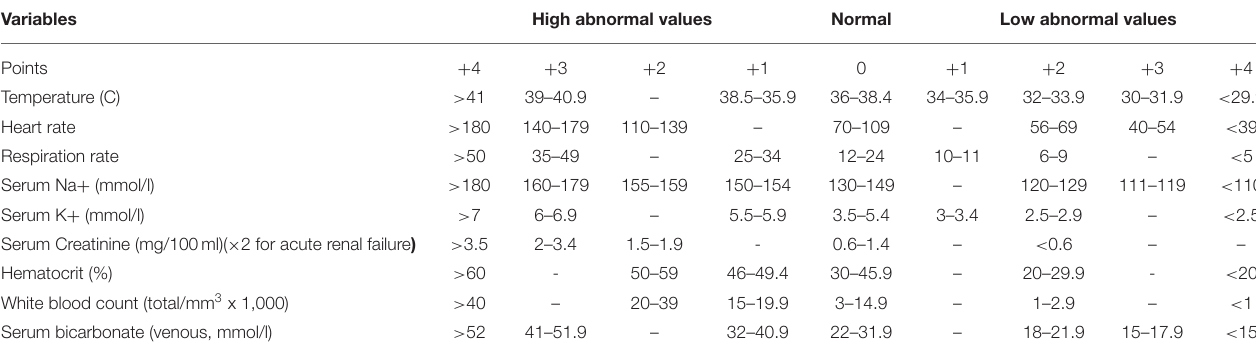
TABLE 1 | Fournier’s Gangrene Severity Index (FGSI): > 9 LRINEC = 75% probability of death; < 9 LRINEC = 78% probability of survival.